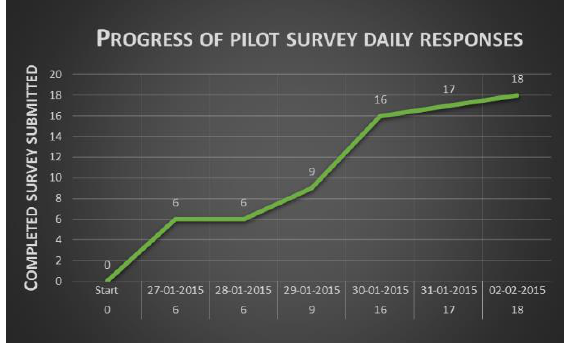
Figure 2. Response to reminder